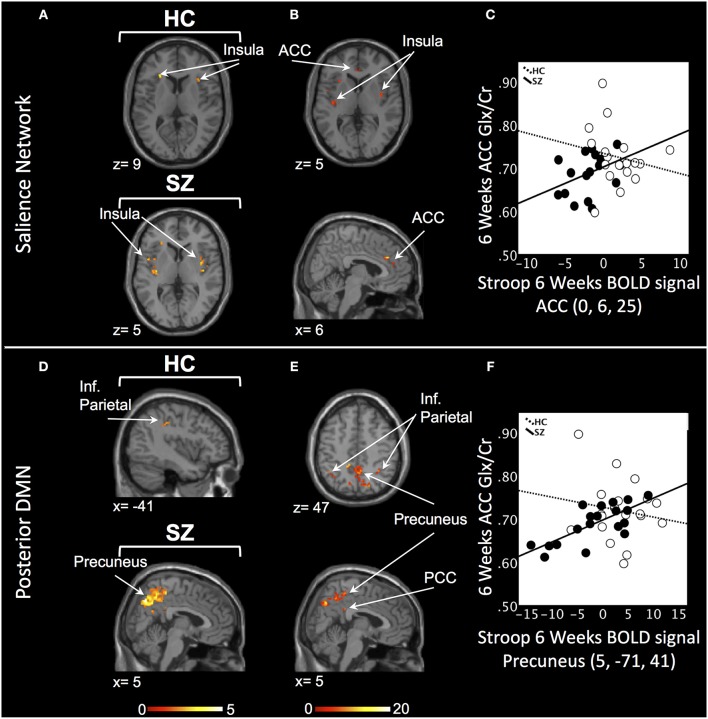
Six weeks relationship between ACC Glx and Stroop BOLD signal. (A) In the salience network, relationship between Glx levels and Stroop BOLD signal in the insula in healthy controls (HC) and in the ACC and insula in medicated patients with schizophrenia (SZ). (B) Six weeks BOLD Stroop group × ACC Glx interaction significant in bilateral insula and ACC in the salience network. (C) Descriptive plot of ACC Glx and ACC Stroop BOLD signal (MNI coordinates 0, 6, 25) reflecting the significant positive correlation in medicated SZ and the lack of correlation in HC. (D) In the posterior default mode network (DMN), relationship between Glx levels and Stroop BOLD signal in the inferior parietal lobule (Inf. Parietal) in HC and in the precuneus, inferior parietal lobule in medicated SZ. (E) Six weeks BOLD Stroop group × ACC Glx interaction significant in the precuneus, PCC, and inferior parietal lobule in the posterior DMN. (F) Descriptive plot of CC Glx and Precuneus Stroop BOLD signal (MNI coordinates 5, −71, 41) reflecting the significant positive correlation in medicated SZ and the lack of correlation in HC. x and z coordinates refer to Montreal Neurological Institute (MNI) space. Color bar on bottom indicates t-score. All analyses were thresholded at PSVC < 0.05.